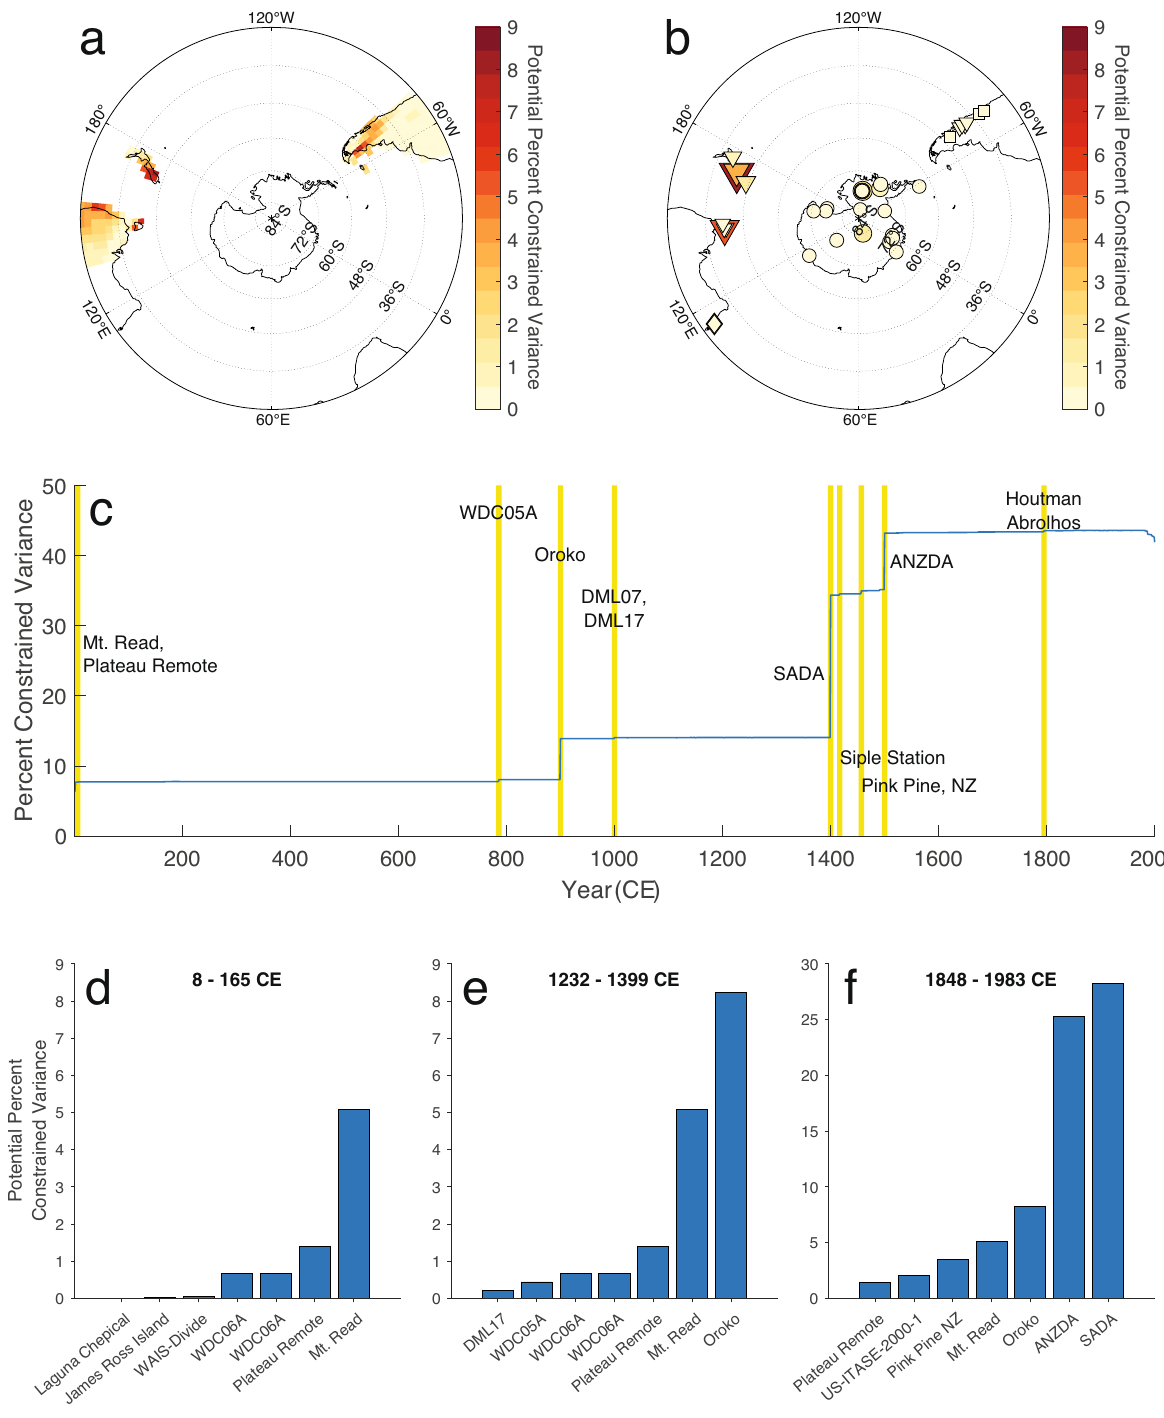
Fig.3|Optimalsensoranalysis.a , b Mapsofthepotentialabilityfordroughtatlas ( a ) and PAGES2k sites ( b ) to constrain reconstruction posterior variance (red shading). c Evolution of reconstruction posterior variance over time. Yellow bars indicatetheadditionoftheindicatedproxytothenetwork. d – f Rankedhistograms